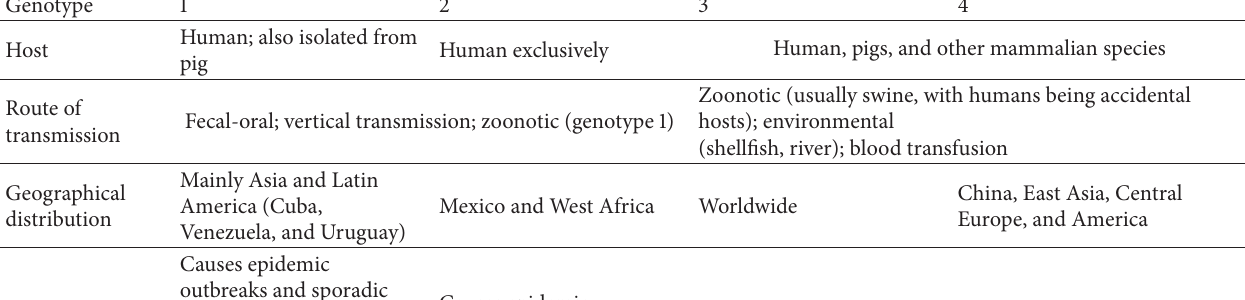
Table 1: Epidemiology and clinical features of hepatitis E virus [3, 6, 10, 20, 21].